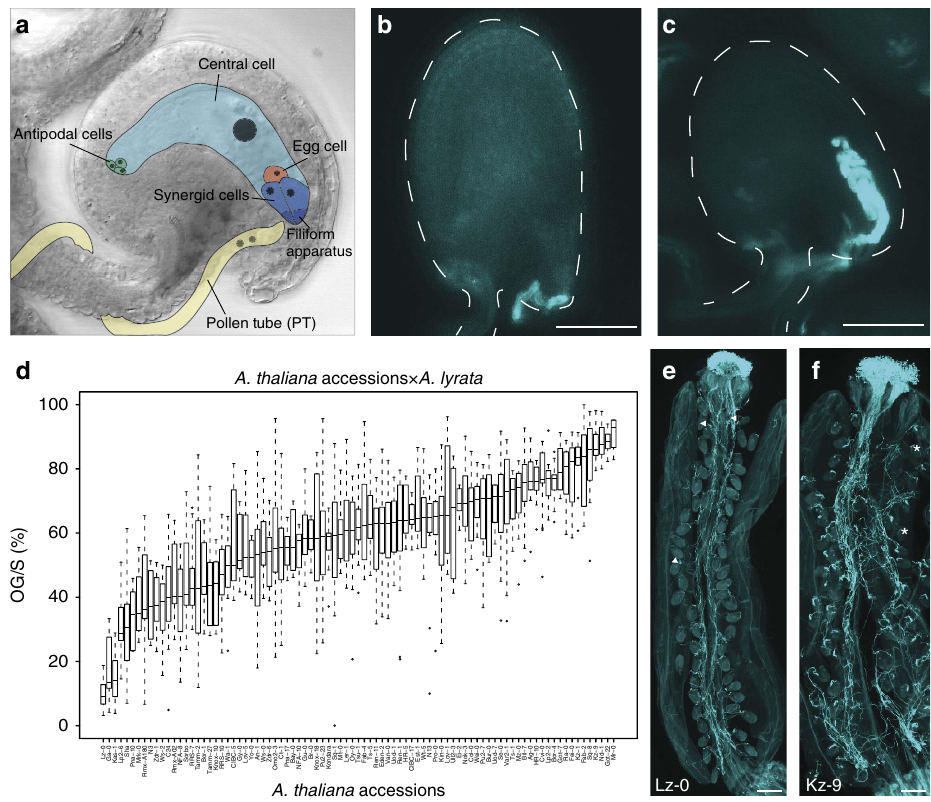
Figure 1 | PT reception in interspecific crosses. ( a ) Diagram of the female gametophyte with its cell types. The synergids with their membrane-rich filiform apparatus are crucial for communication with the arriving PT. ( b ) Ovule with normal PTreception, visualized by callose staining of the PTcell walls with Aniline Blue. The PT stopped its growth and ruptured. Dashed line indicates outline of the ovule. ( c ) Ovule with PT overgrowth. The PT continues growing inside the female gametophyte. Dashed line indicates outline of the ovule. ( d ) Natural variation in the proportion of ovules with PTovergrowth per silique (OG/S) in 86 A. thaliana accessions that were pollinated with A. lyrata pollen. OG/S varies between 10% and more than 90%, depending on the genotype of the mother. ( e ) A silique of Lz-0 pollinated with A. lyrata pollen. Most of the ovules show normal PTreception. Ovules with PTovergrowth are marked with an arrowhead. ( f ) A silique of Kz-9 pollinated with A. lyrata pollen. Most of the ovules display PT overgrowth. Asterisks mark ovules with normal PT reception. Per accession and per pollen donor, 5–10 siliques were analysed. Scale bars, 50 m m ( b and c ), 250 m m ( e and f ).